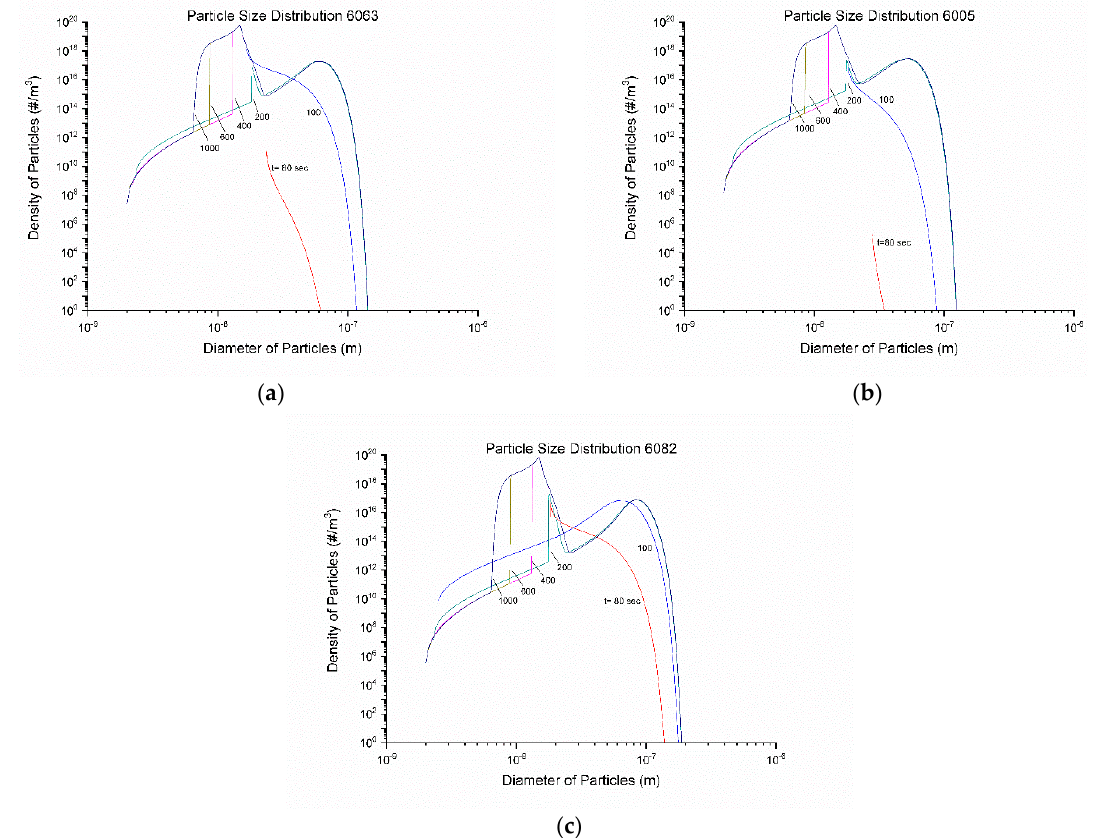
Figure 14. Evolution of particle size distributions (PSD) of Mg 2 Si precipitates with time during homogenization cooling, ( a ) 6063, ( b ) 6005, and ( c ) 6082 alloy.